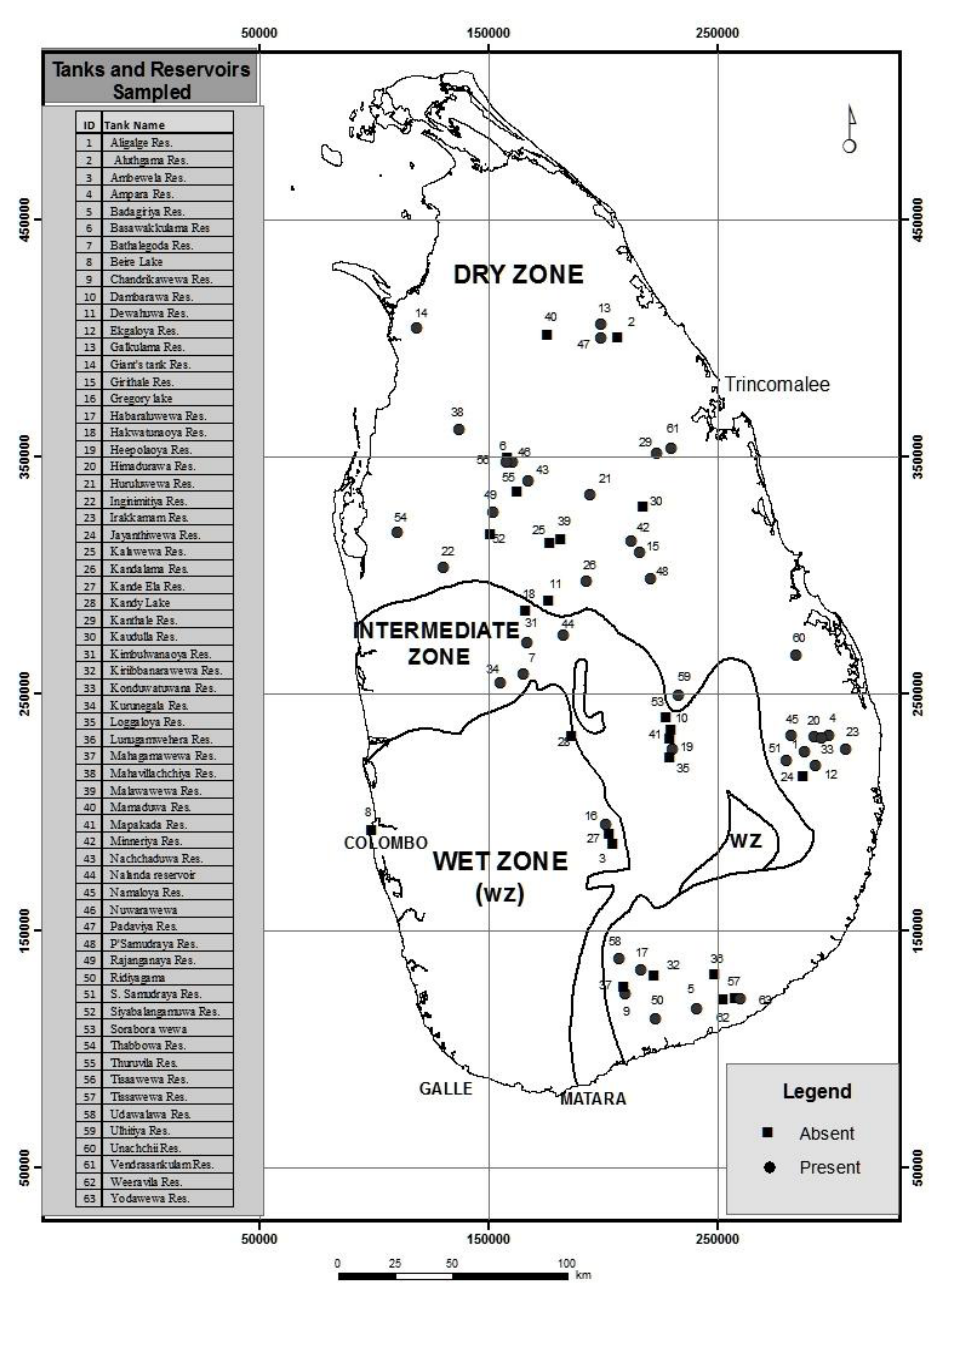
Figure 1: Locations of the 63 study reservoirs in Sri Lanka (closed circle indicate the 38 reservoirs which contain C. raciboskii ). The country is divided into three main climatic regions: the Dry Zone, the Intermediate Zone, and the Wet